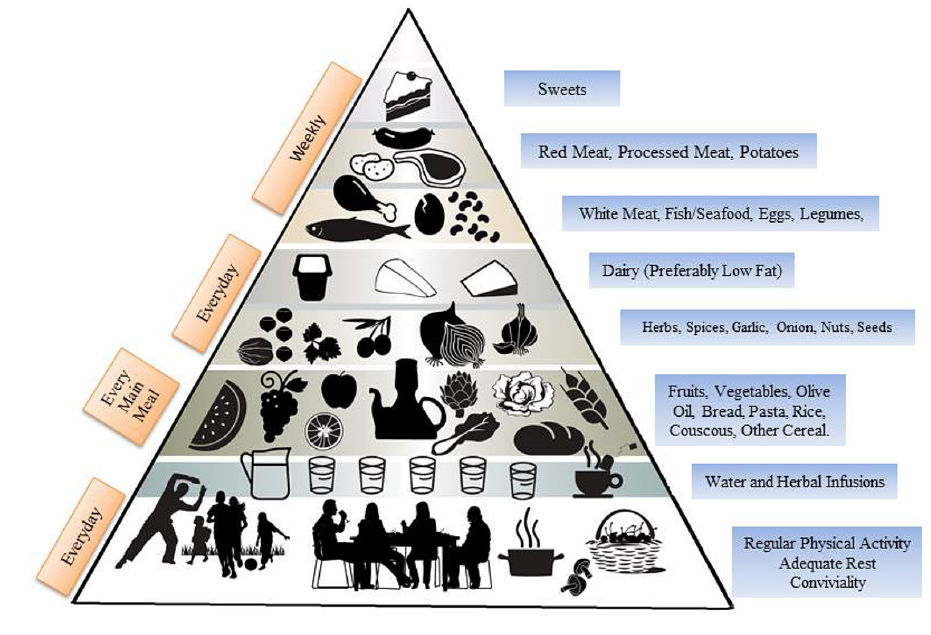
Figure 1. Mediterranean diet pyramid: a lifestyle for today (Bach-Faig et al.